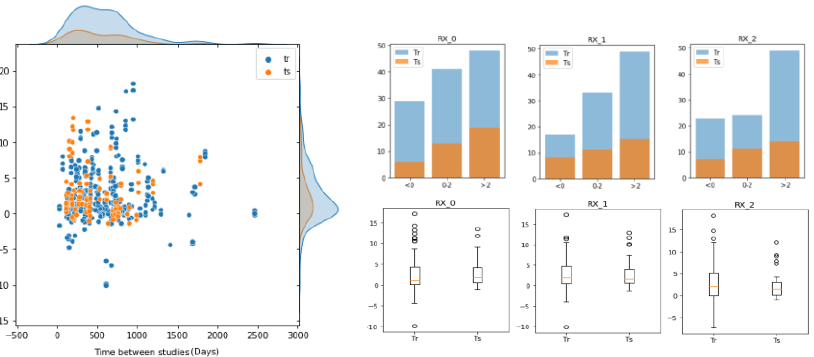
Figure 5. Description of the training and test set cohorts in terms of tumour growth size (in mm), time between studies (days) and the annotators